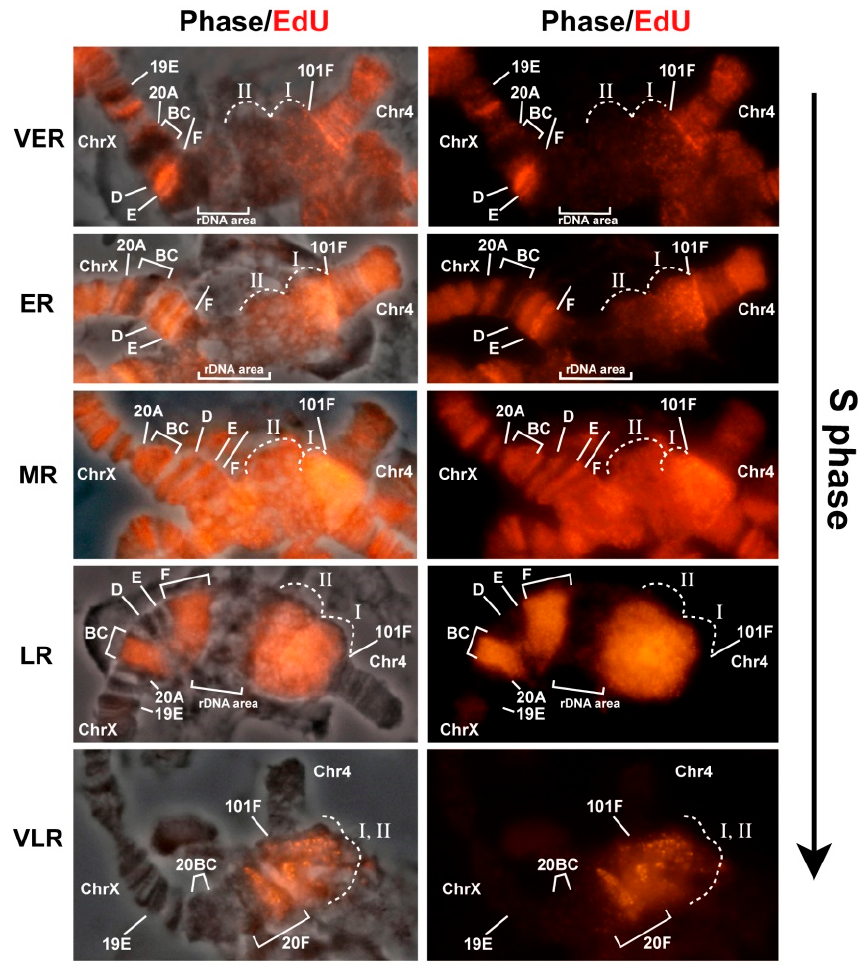
Figure 10. Sequential patterns of pulse EdU incorporation into the pericentromeric region of the X-4 chromosome. The left panel is a superposition of the EdU signal on a phase contrast image, and the right panel depicts EdU data. The stages of replication are presented in accordance with Figure 8. The exposure parameters are not identical among di ff erent stages and were selected for the most convenient mapping of pericentromeric signals.